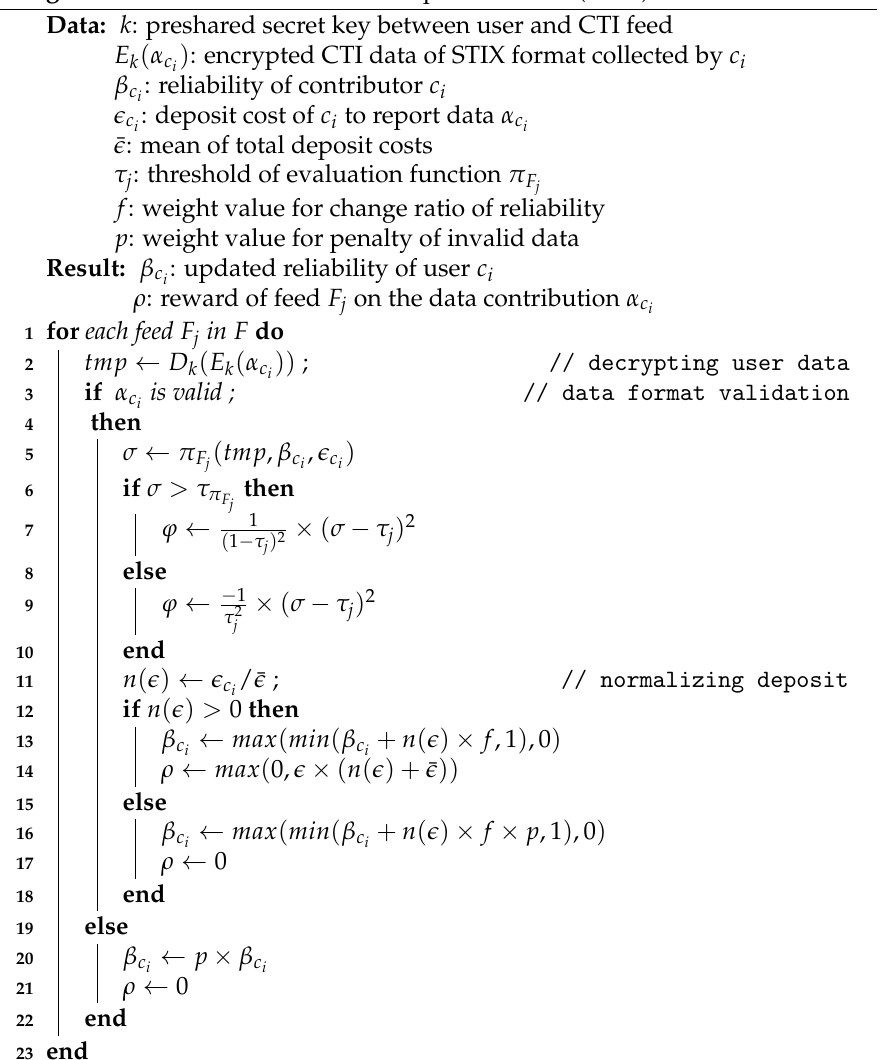
Algorithm 2: Pseudocode of Data Report Contract ( DRC